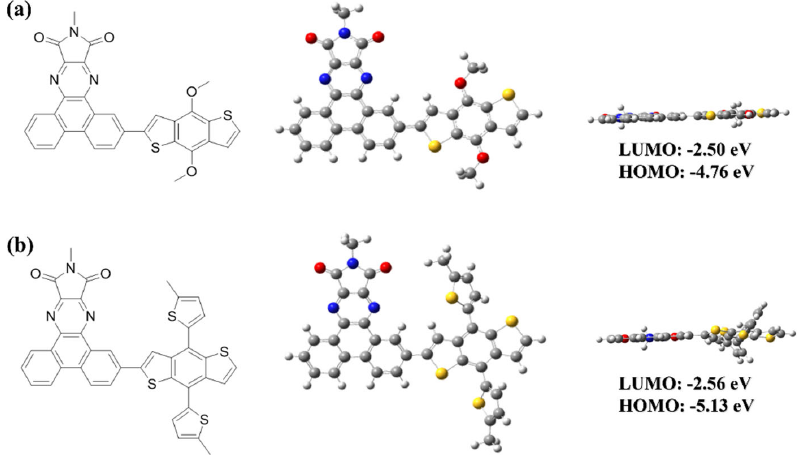
Figure 2. Chemical structures and FMO energy levels of ( a ) P(BPQI ‐ BDT) and ( b ) P(BPQI ‐ BDTT).